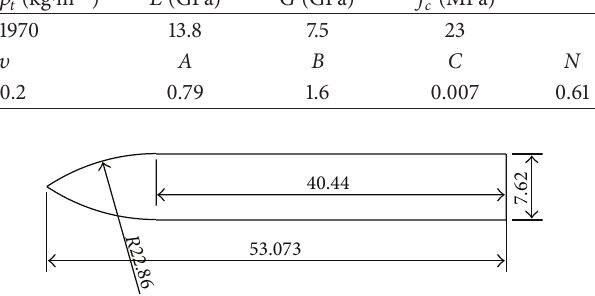
Figure 1: Projectile geometries [9] (unit: